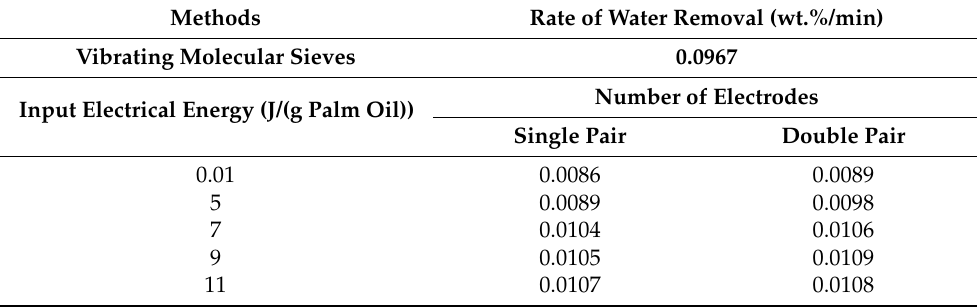
Table 2. Comparison of water removal rates between rotary-vibrating molecular sieves and electroly- sis via